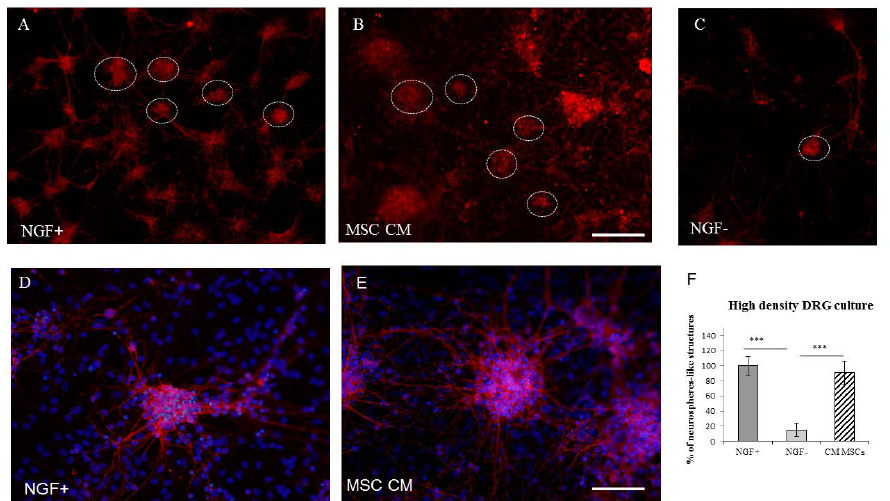
Figure 1. Formation of neurosphere-like structures (shown in white circles) from TUJ1 positive PCDRGs plated in high-density, supplemented: with NGF ( A , D ); with MScCM ( B , E ); and without NGF ( C ). Quantification of neurosphere-like structures ( F ). *** p < 0.001 indicate significant differences between groups. Scale bars: ( A – C ) = 400 µ m; and ( D , E ) = 100 µ m.